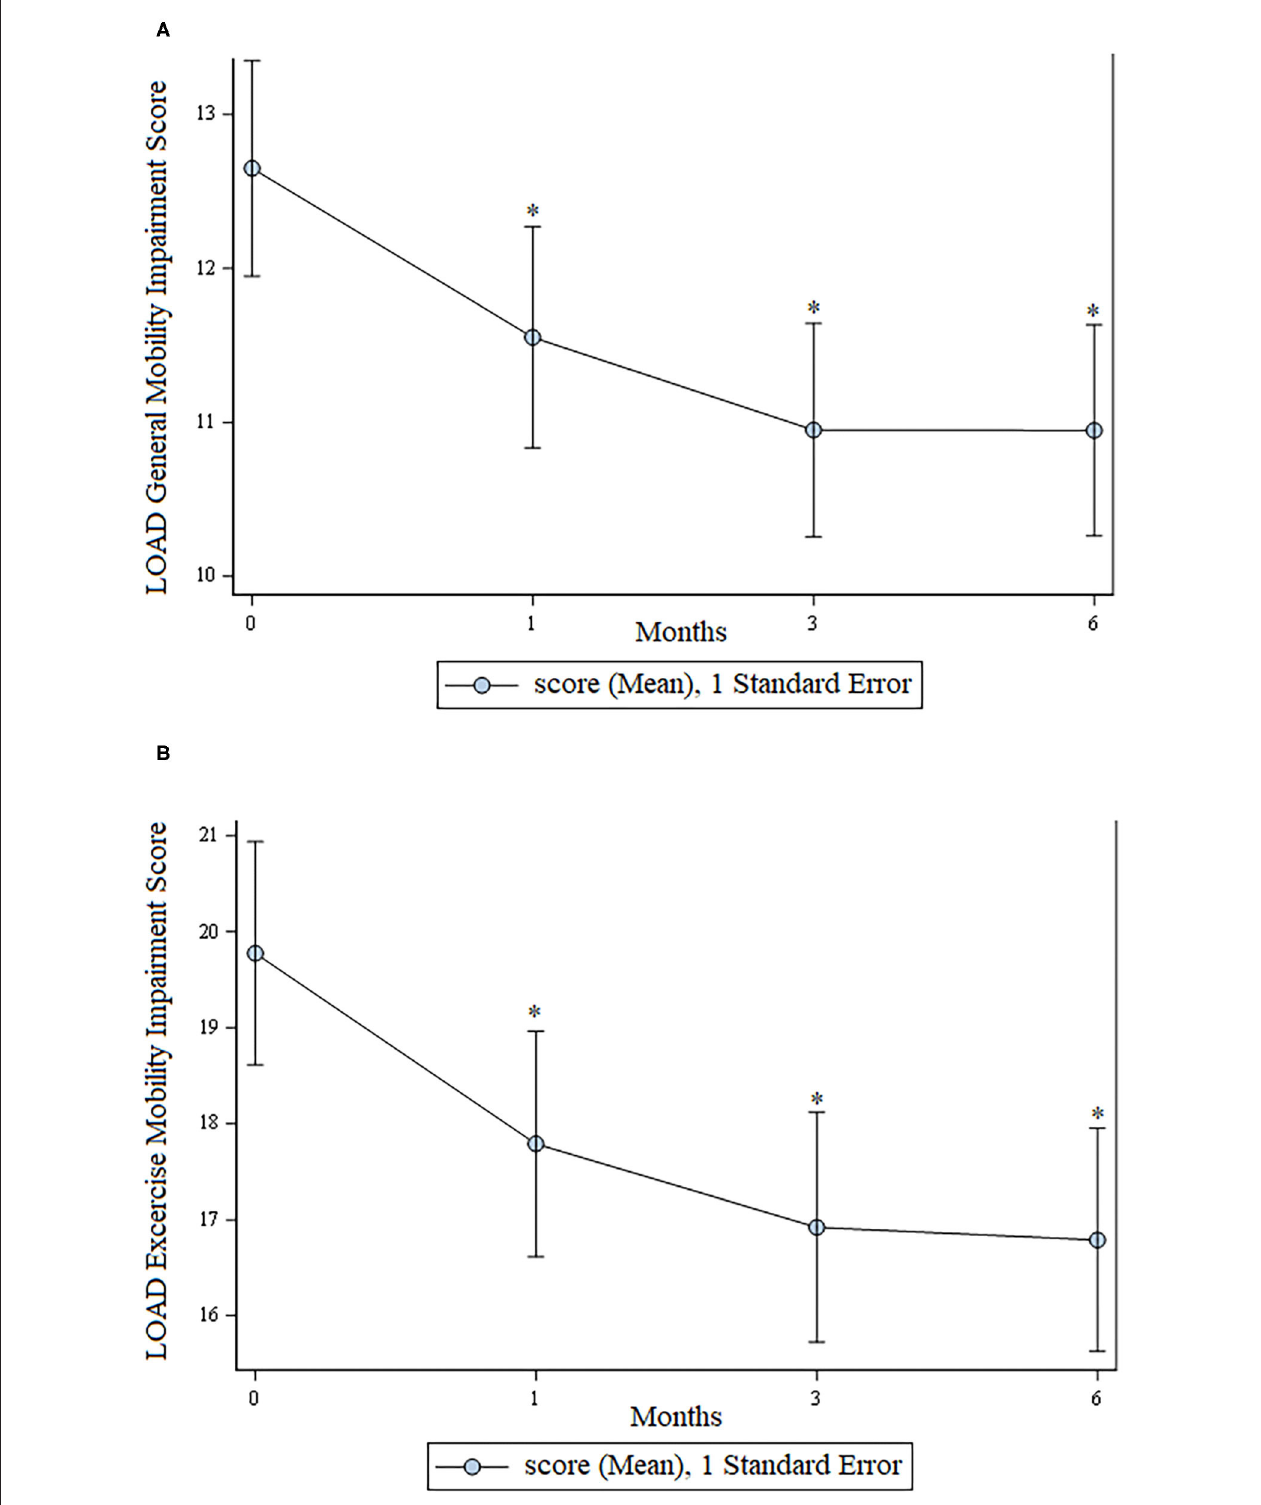
FIGURE 2 | LOAD scores. (A) Mobility in general; (B) Mobility at exercise. For both graphs, lower scores are consistent with greater mobility. In both graphs an * indicates a significant ( p < 0.05) change from baseline.